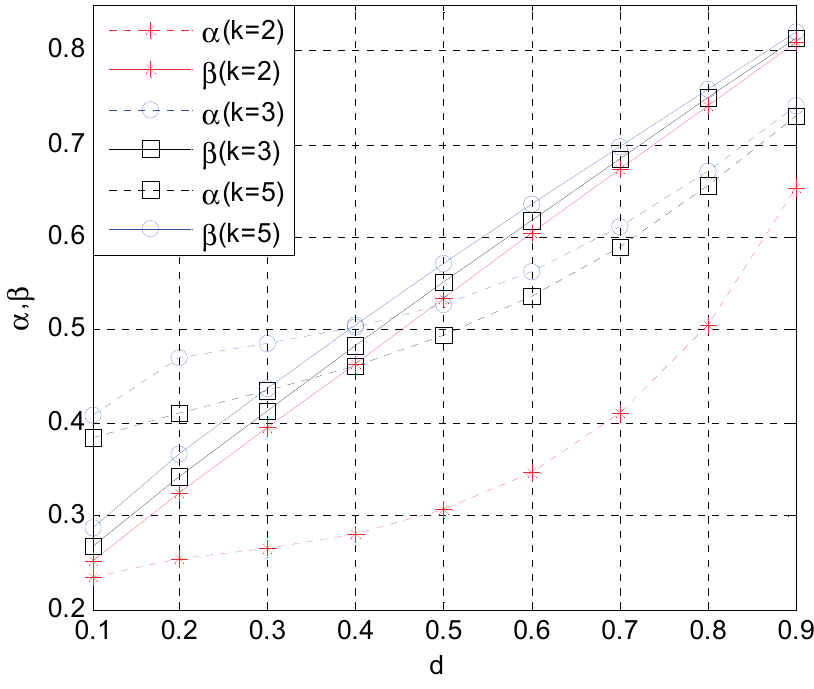
Figure 4. Optimal time allocation strategy α * and optimal bandwidth strategy β * versus distance d between secondary user and primary transmitter with different numbers of